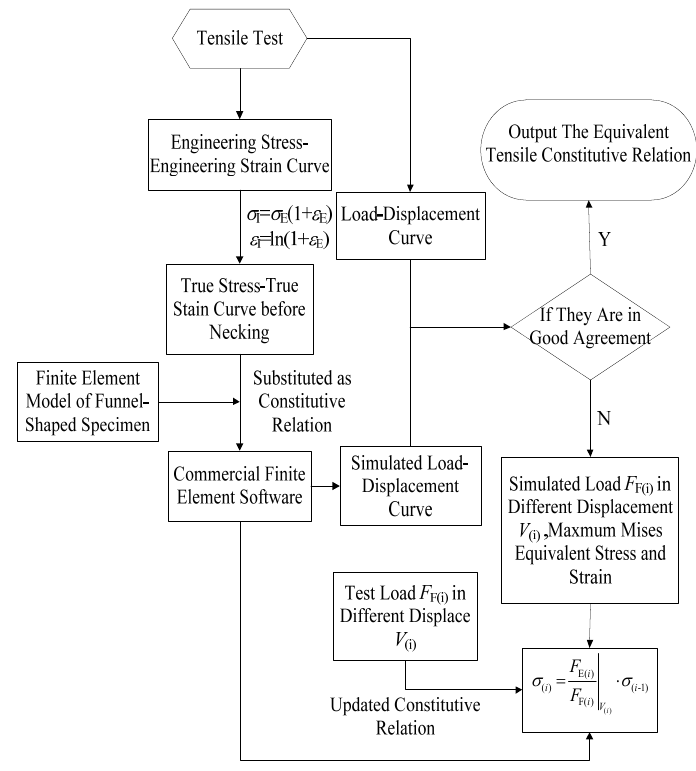
Figure 1. Flowchart for the FAT method’s data processing [24].